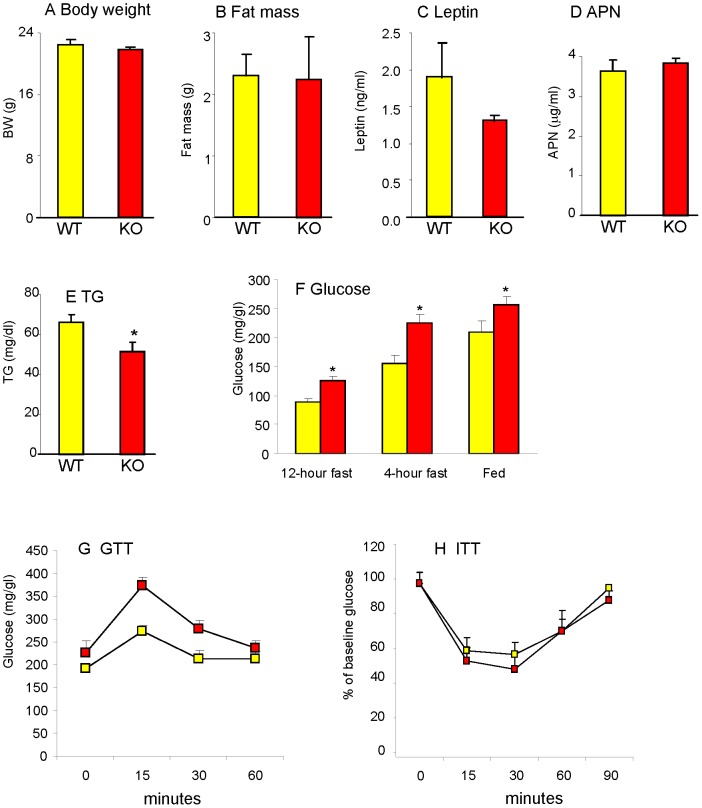
Adiposity and glucose metabolism in young Gal-3 KO mice.Body weight (A), fat mass (B), plasma levels of leptin (C), APN (D) and TG (E) as well as blood levels of glucose (F) were evaluated in chow-fed 12-week-old WT (yellow) and Gal-3 KO (red), mice. Glucose tolerance test (G) was performed on 4-hour fasted mice. Insulin tolerance test (H) was performed on fed mice. Data are mean+/−SEM, n = 5. *p<0.05 versus WT mice.